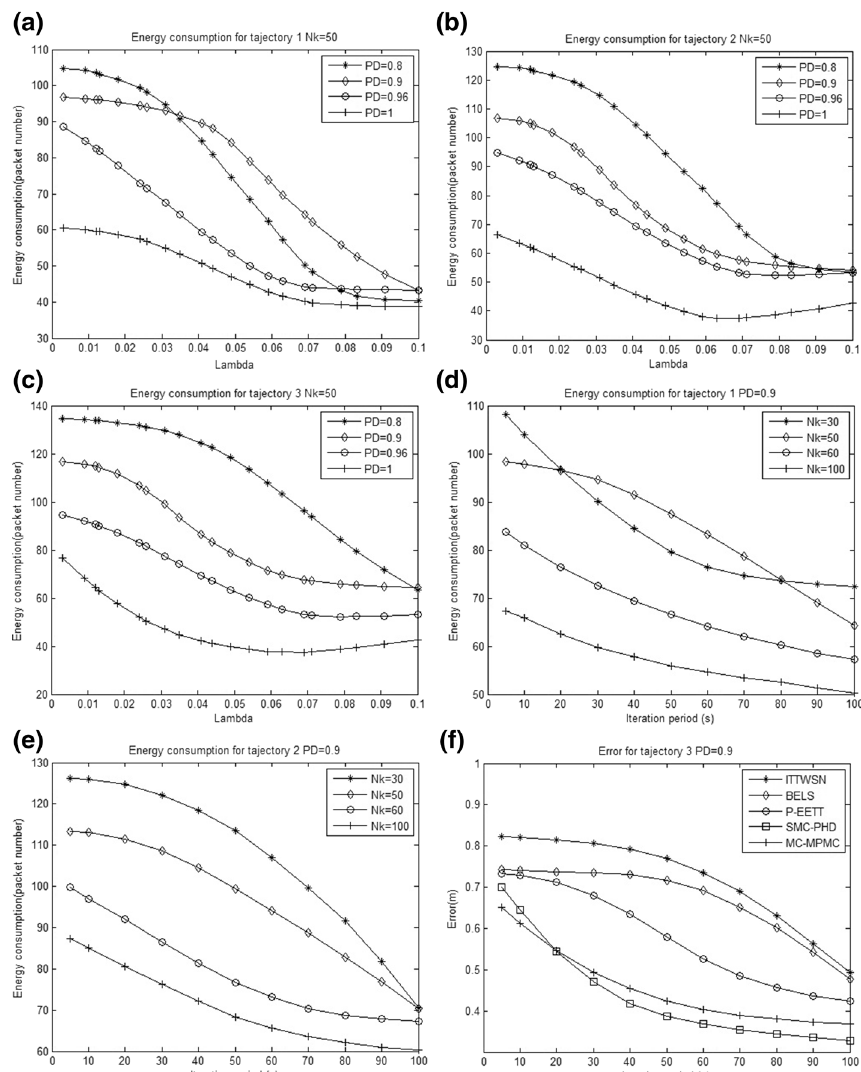
Fig. 6 a – c Tracking energy consumption related to detected probability p D based on node density (cid:31) 0 . a Trajectory 1; b Trajectory 2; c Trajectory 3; d – f Tracking energy consumption related to samples N k based on iteration periods; d Trajectory 1; e Trajectory 2; f Trajectory